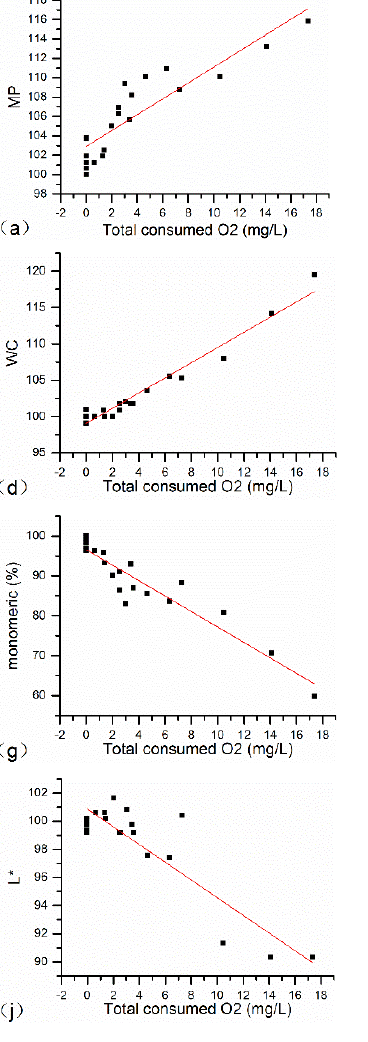
( c ), WC ( d ), CDRSO 2 ( e ), CD ( f ), monomeric (%) ( g ), polymeric (%) ( h ), b* ( i ), L* ( j ), H*ab ( k ), and ∆ E ( l ) of all the wines before and after each oxygenation cycle. In all cases, initial values were normalized to 100% by initial values. Abbreviations: MP, monomeric pigments; SPP, small polymeric pigments; LPP, large polymeric pigments; WC, total color of free anthocyanins and anthocyanins eventually involved in bisulfite adducts; CDRSO 2 , color due to derivatives resistant to SO 2 bleaching; CD, color density; polymeric, polymeric anthocyanins; monomeric, monomeric anthocyanins;